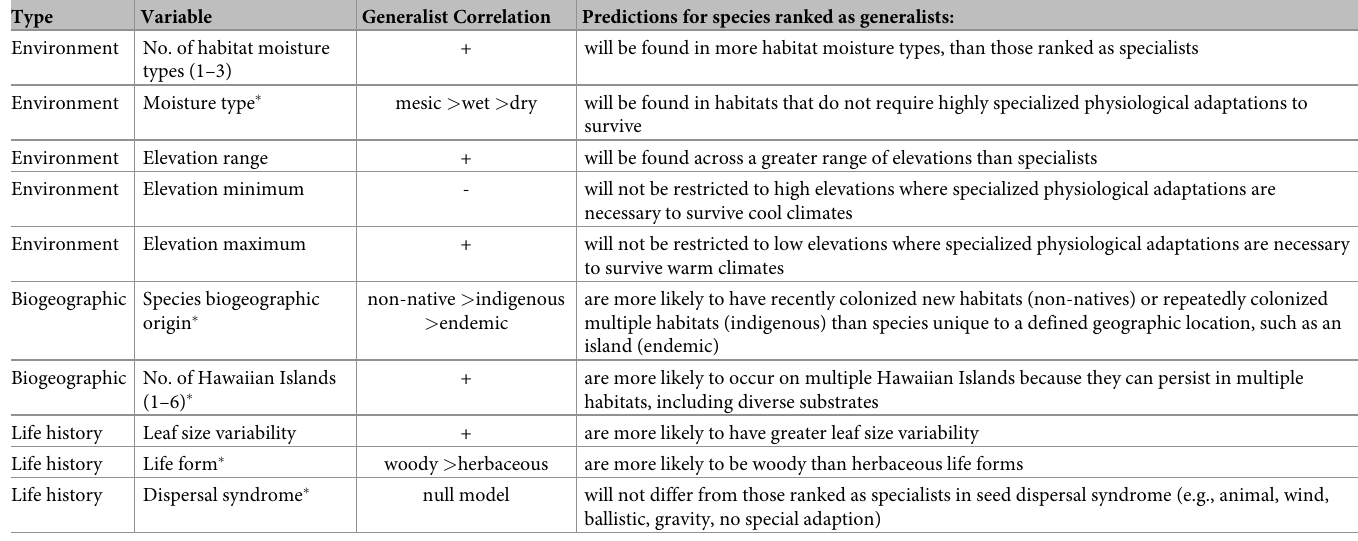
Table 1. Hypotheses to test the validity of species habitat specialization rankings with known species’ environmental and biogeographic ranges and to identify spe- cies’ traits that can be used to predict species location along the habitat specialization